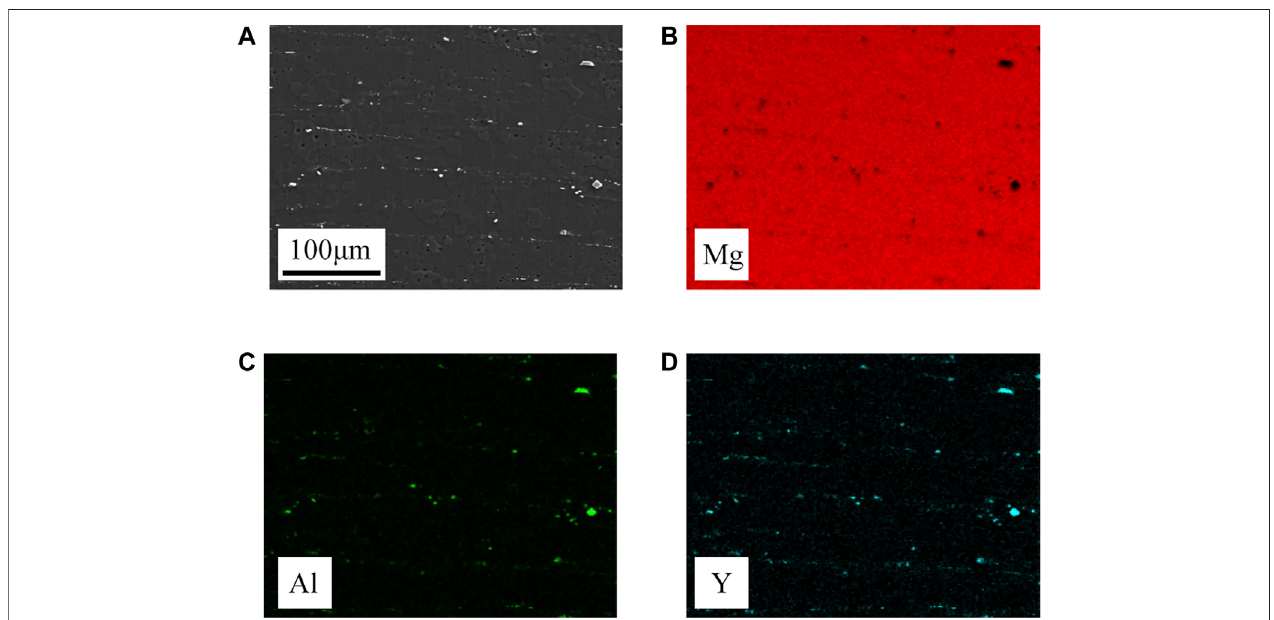
FIGURE 3 | Microstructures of the LAY410 alloy.